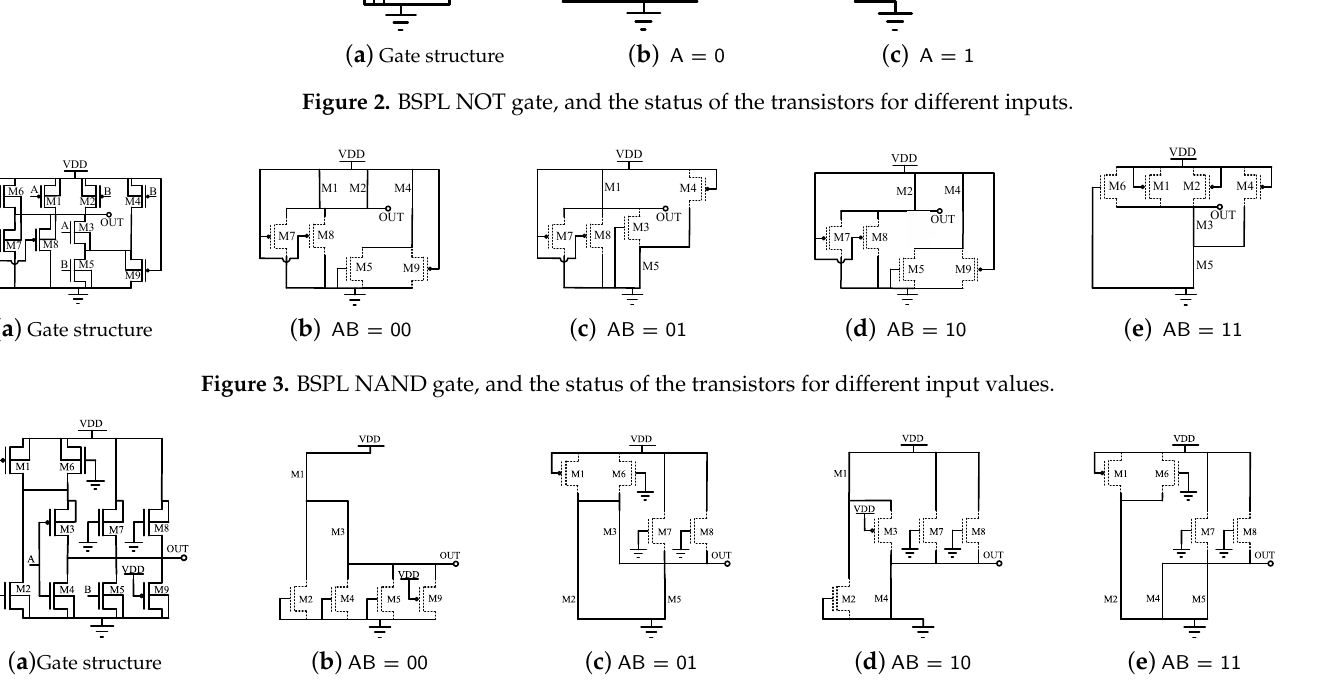
Figure 4. BSPL NOR gate, and the status of the transistors for different input